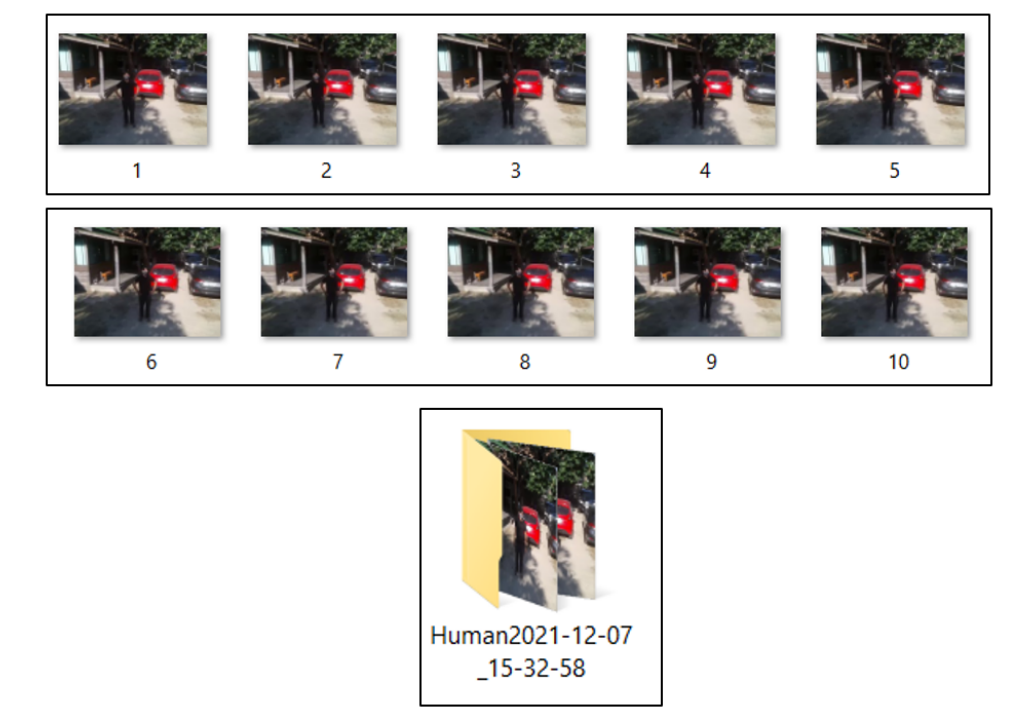
Figure 26. A series of 10 pictures saved in a created folder